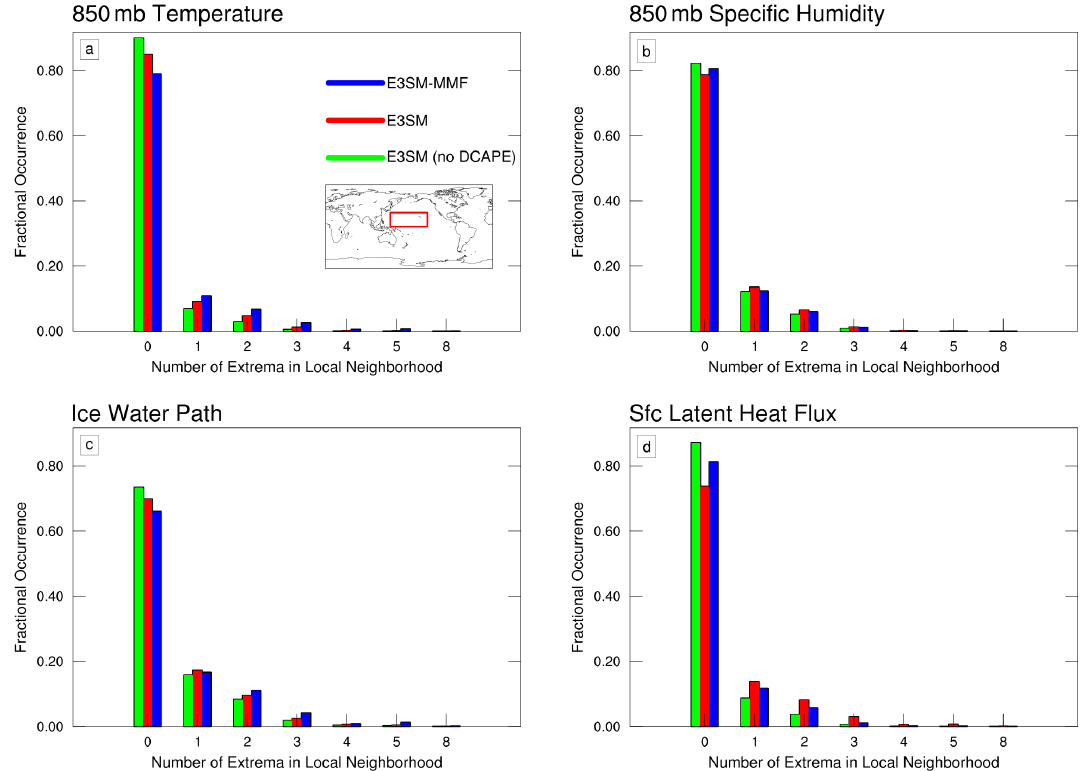
Figure 8. Similar to Fig. 7, showing fractional occurrence of neighborhood patterns over the region 0–30 ◦ N, 140–220 ◦ E for various model variables that do not exhibit a checkerboard pattern, specifically 850mb temperature (a) , 850mb zonal wind (b) , ice water path (c) , and surface latent heat flux (d) .